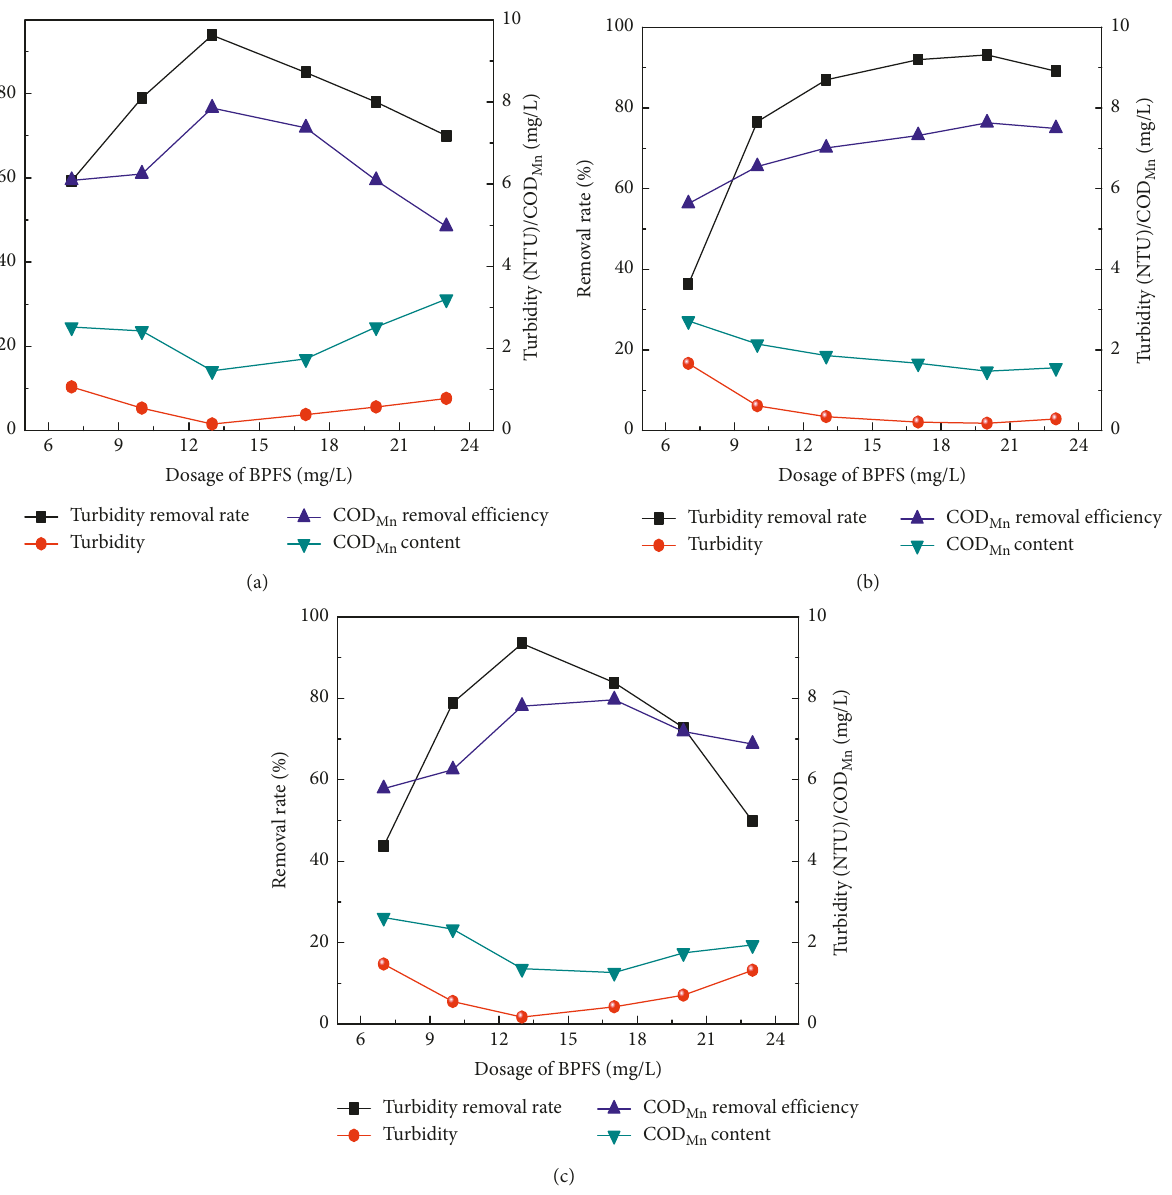
3 BPFS; (b) 60 kg/m 3 BPFS; (c) 80 kg/m 3